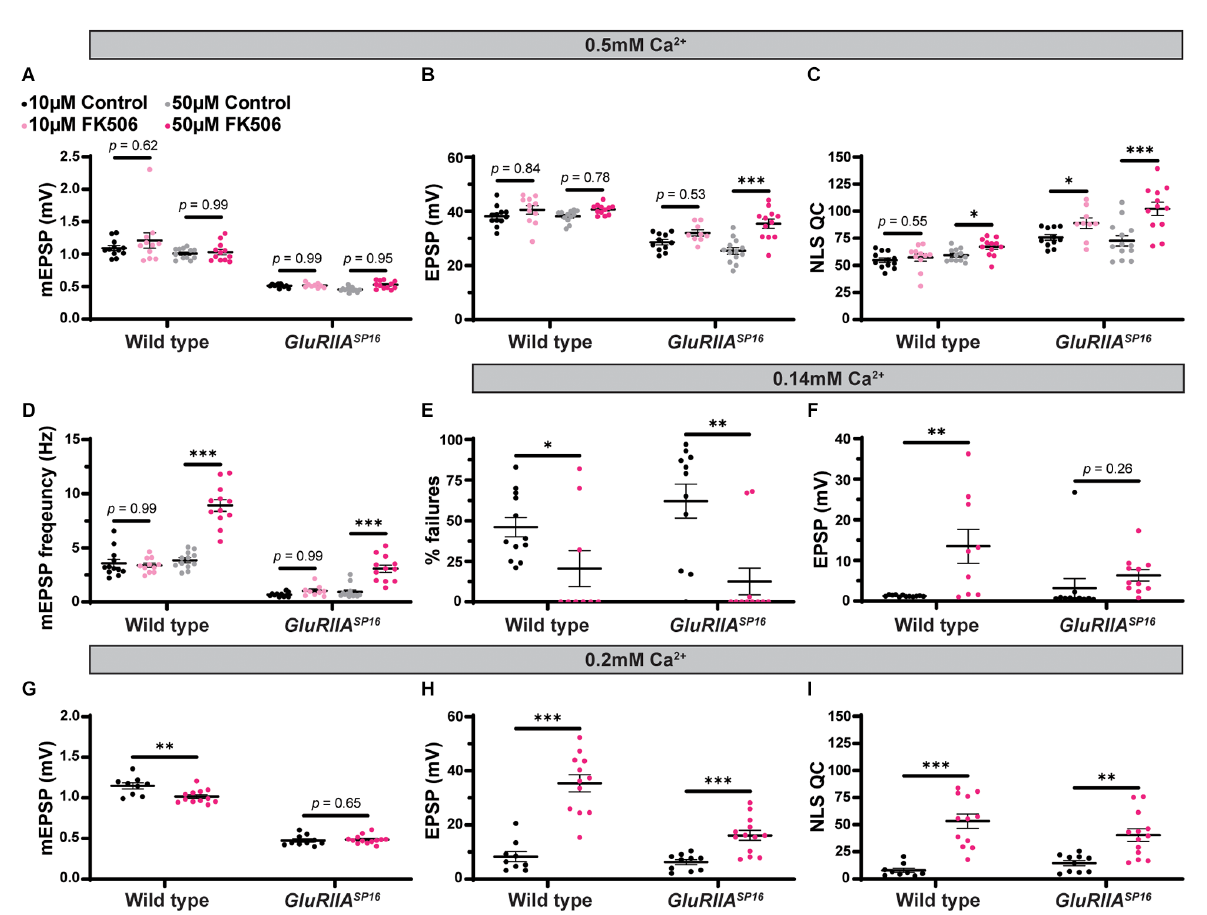
FIGURE11 Maintenance of presynaptic homeostatic potentiation can be further potentiated by pharmacologically inhibiting calcineurin. (A–D) Quantification showing average mEPSP amplitude, EPSP amplitude, NLS quantal content, and mEPSP frequency in wild type and GluRIIA SP 16 animals. Black points show 10 µ M DMSO control, light pink points show 10 µ M FK506, gray points show 50 µ M DMSO control, and dark pink points show 50 µ M FK506. (E,F) Quantification of failure analysis experiment. 0.10 mM Ca 2+ was used in this experiment. “% failures” represents the number of stimulation pulses that failed to elicit any discernable response out of the 100 total pulses per synapse. Black points represent DMSO control, while the dark pink points represent 50 µ M FK506. (G–I) Quantification showing average mEPSP amplitude, EPSP amplitude, and NLS quantal content in wild type and GluRIIA SP 16 animals dissected in low calcium conditions (0.20 mM Ca 2+ ). Black points represent DMSO control, while the dark pink points represent 50 µ M FK506. ∗ p < 0.05, ∗∗ p < 0.01, ∗∗∗ p < 0.001 by Student’s T-test vs. non-drugged